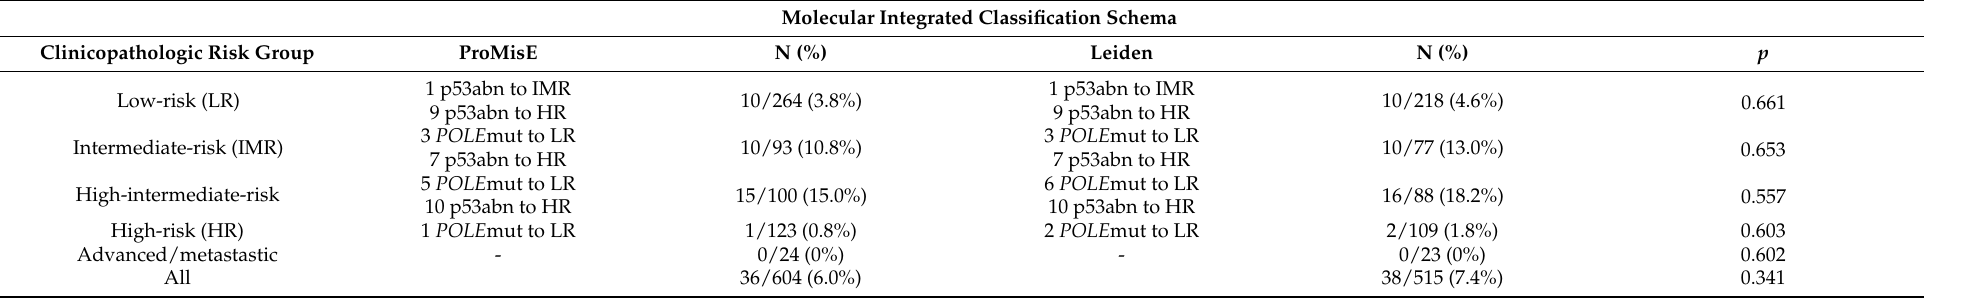
Table 3. Shift of patients between prognostic risk groups by molecular integrated classification